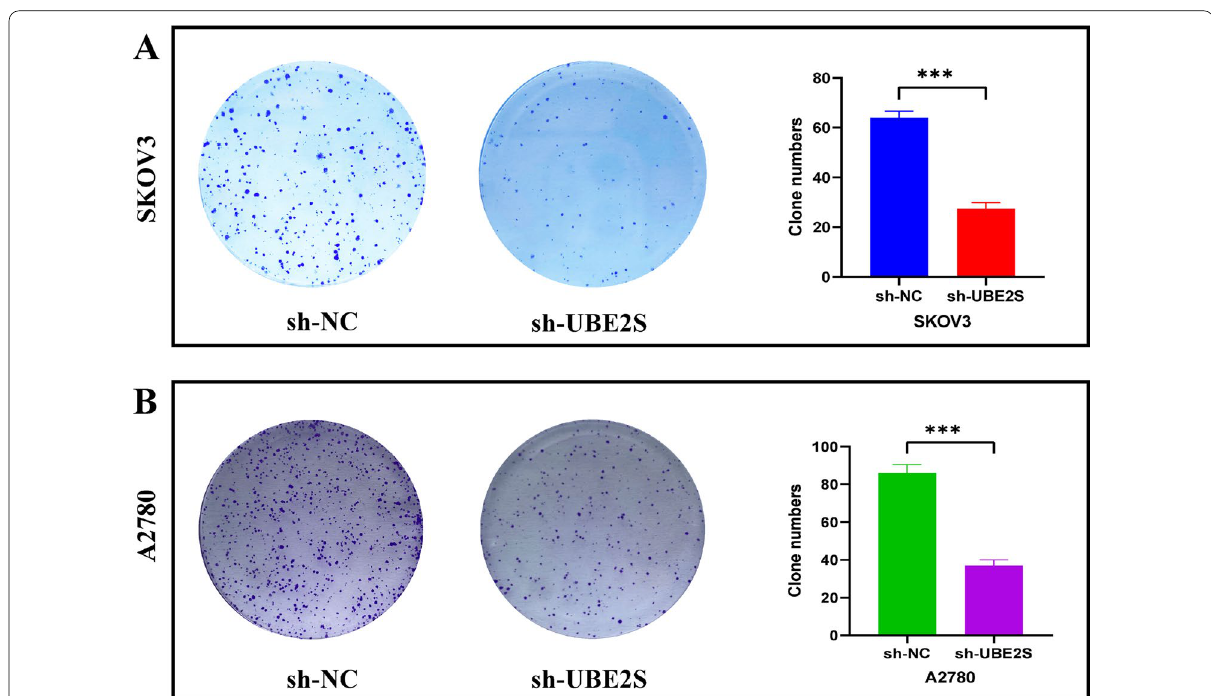
Fig. 8 The effect of UBE2S gene knockdown on the clonogenic assay. A The results and statistics of cell clone formation assay of SKOV3 cell lines after cell transfection. B The results and statistics of cell clone formation assay of A2780 cell lines after cell